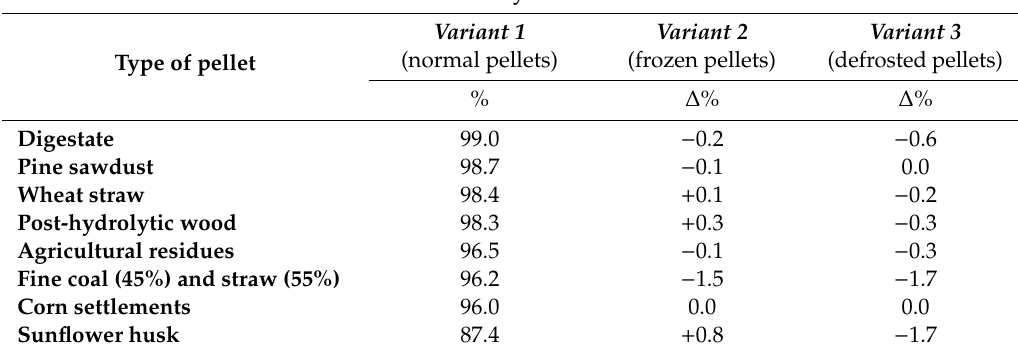
Table 2. Mechanical durability of commercial pellets from biomass and its variations in three storage conditions. Mechanical Durability and Its Variations * Type of